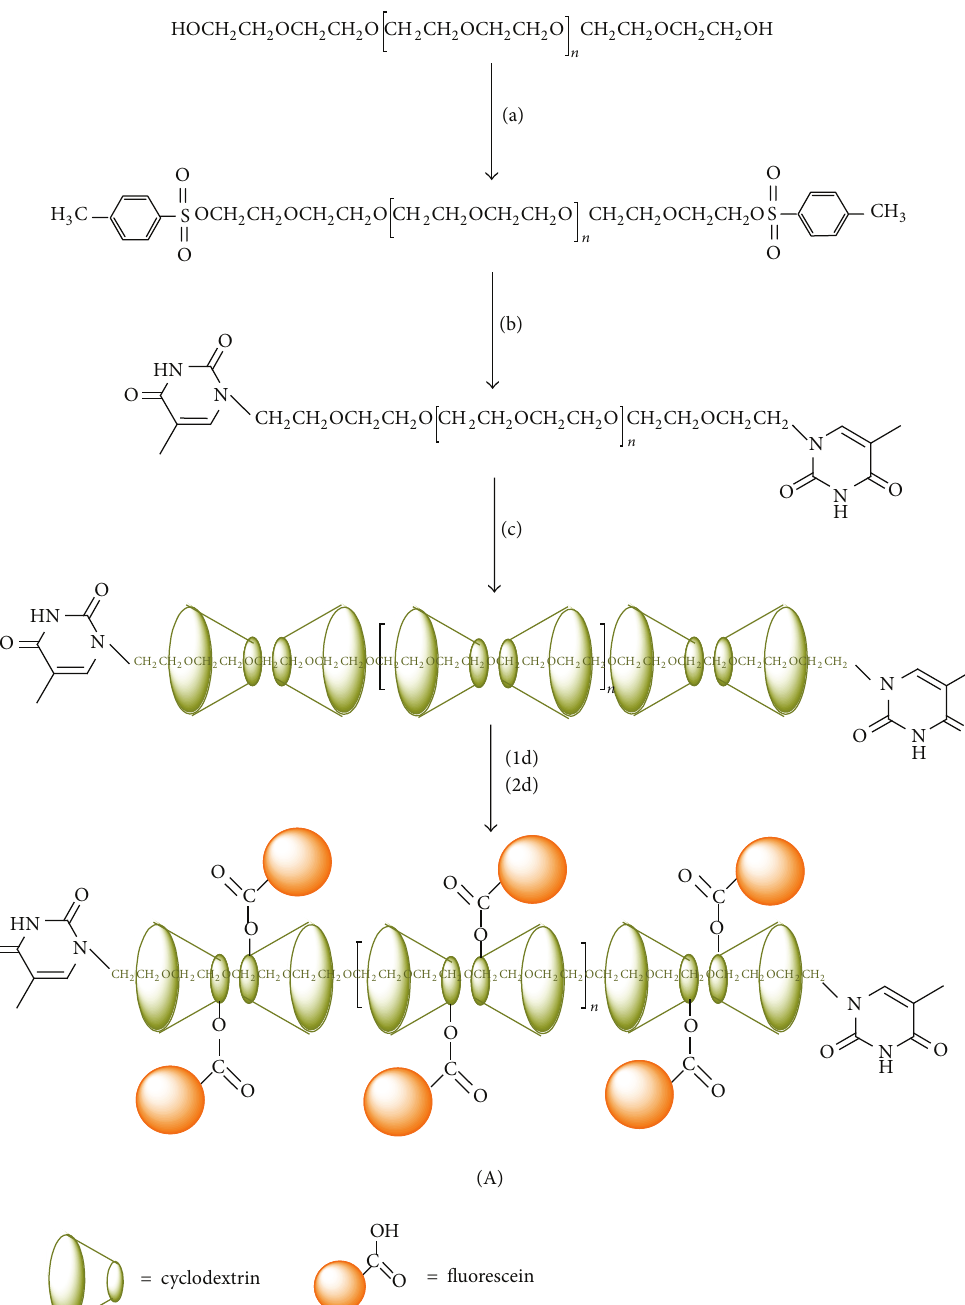
Scheme 1: Representation of the functionalization of polyethylene glycol and synthesis of pseudopolyrotaxane and finally primary drug delivery system. TsCl/CH 2 Cl 2 /NEt 3 /45 ∘ (a), thymine/KOH/DMF/H 2 O/2 days/70 ∘ (b), cyclodextrin/r.t/3 h (c), KOH/H 2 O (1d), fluorescein/DMF/24 h/r.t